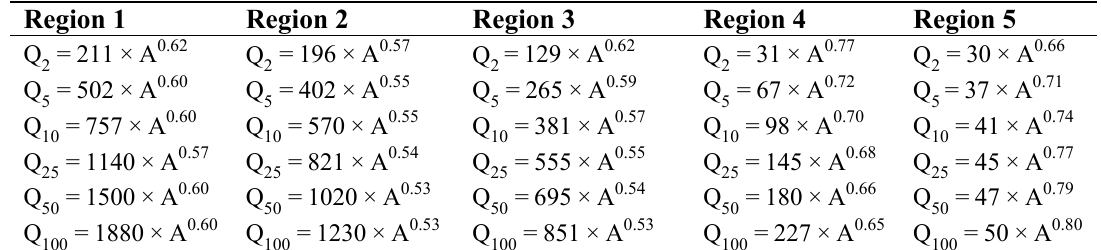
Table 2. Lara (1987) [35] USGS regional regression equations for the state of Iowa.